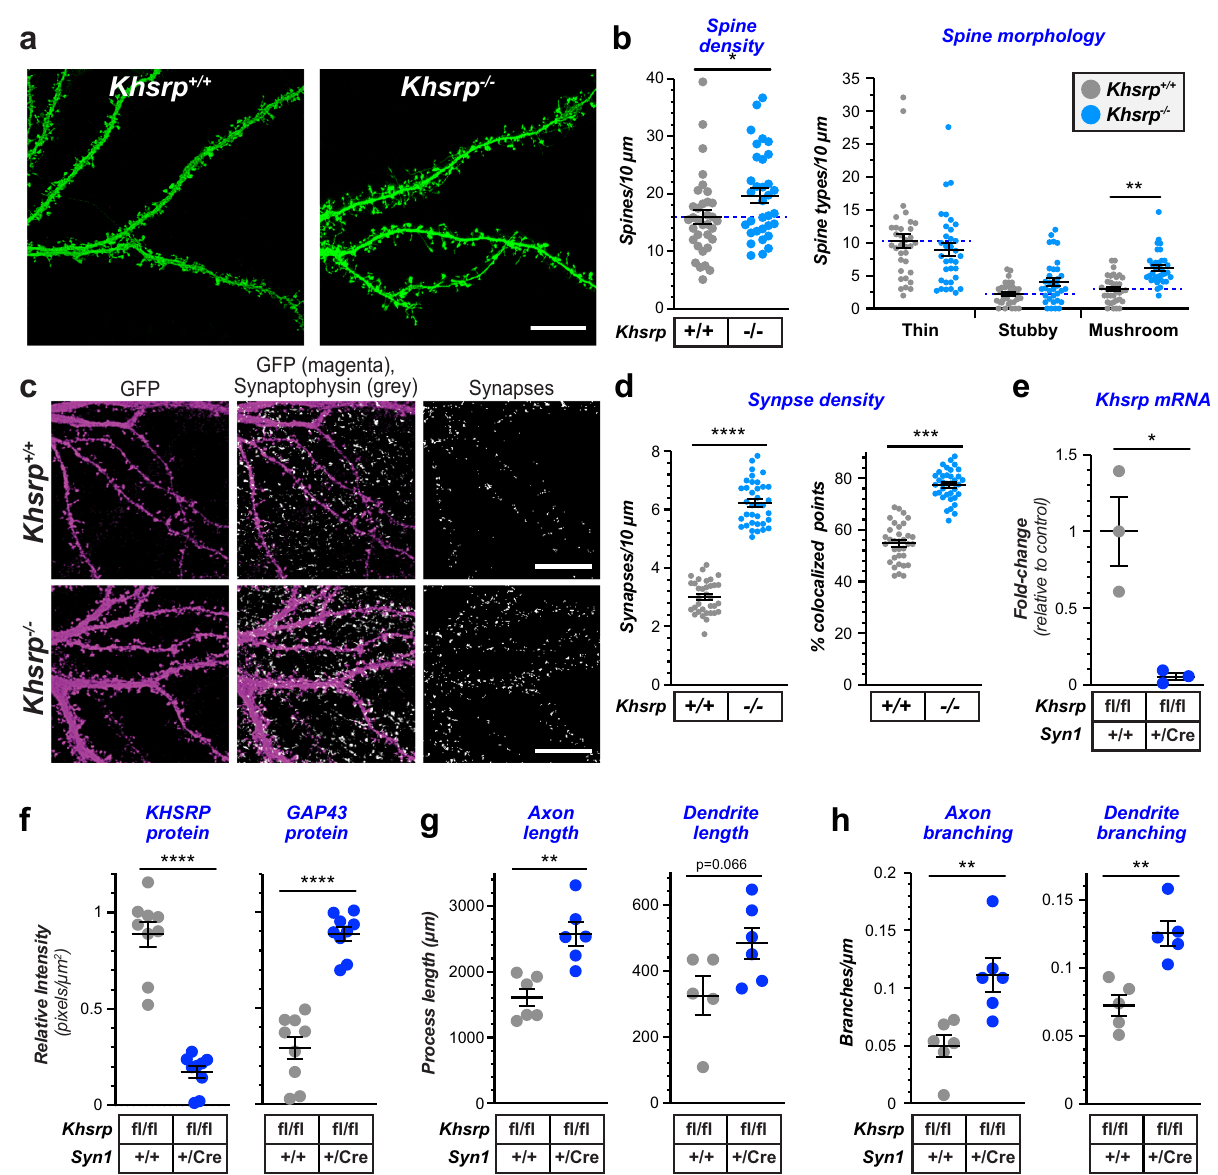
Fig. 4 Altered neuronal growth is through neuron-intrinsic functions of KHSRP. a Representative epi fl uorescent images of distal dendrites for DIV23 cultures of LV-GFP transduced neocortical neurons from E18 Khsrp + / + and Khsrp − / − mice shown as indicated. b Quanti fi cation of dendritic spine density and morphology for cortical neurons as in a is shown ( N > 30 neurons in at least 3 separate cultures; * p ≤ 0.05 and ** p ≤ 0.01 by Student ’ s t test). c Representative epi fl uorescent images of distal dendrites for DIV23 cortical neuron cultures immunostained for GFP (magenta) and synaptophysin (gray). d Quanti fi cation of synapse density and % colocalization of pre- and post-synaptic markers for cortical neurons as in c is shown ( N ≥ 30 neurons in at least 3 separate culture preparations; *** p ≤ 0.005 and **** p ≤ 0.001 by Student ’ s t test). e , f Quanti fi cation of Khsrp mRNA by RTddPCR and KHSRP and GAP43 proteins by immuno fl uorescence in E18 neocortical neurons cultured from Khsrp fl / fl and Khsrp fl / fl × Syn1:Cre mice is shown ( N ≥ 30 neurons in at least 3 separate culture preparations; **** p ≤ 0.001 by Student ’ s t test). g , h Quantitation of axon and dendrite length ( g ) and branching ( h ) for neocortical neurons from E18 Khsrp fl / fl and Khsrp fl / fl × Syn1:Cre mice shown as indicated. Axons were identi fi ed by immunostaining for SMI312 and dendrites by Tau as in Fig. 3 ( N ≥ 60 neurons over 3 separate culture preparations; ** p ≤ 0.01 by Student ’ s t